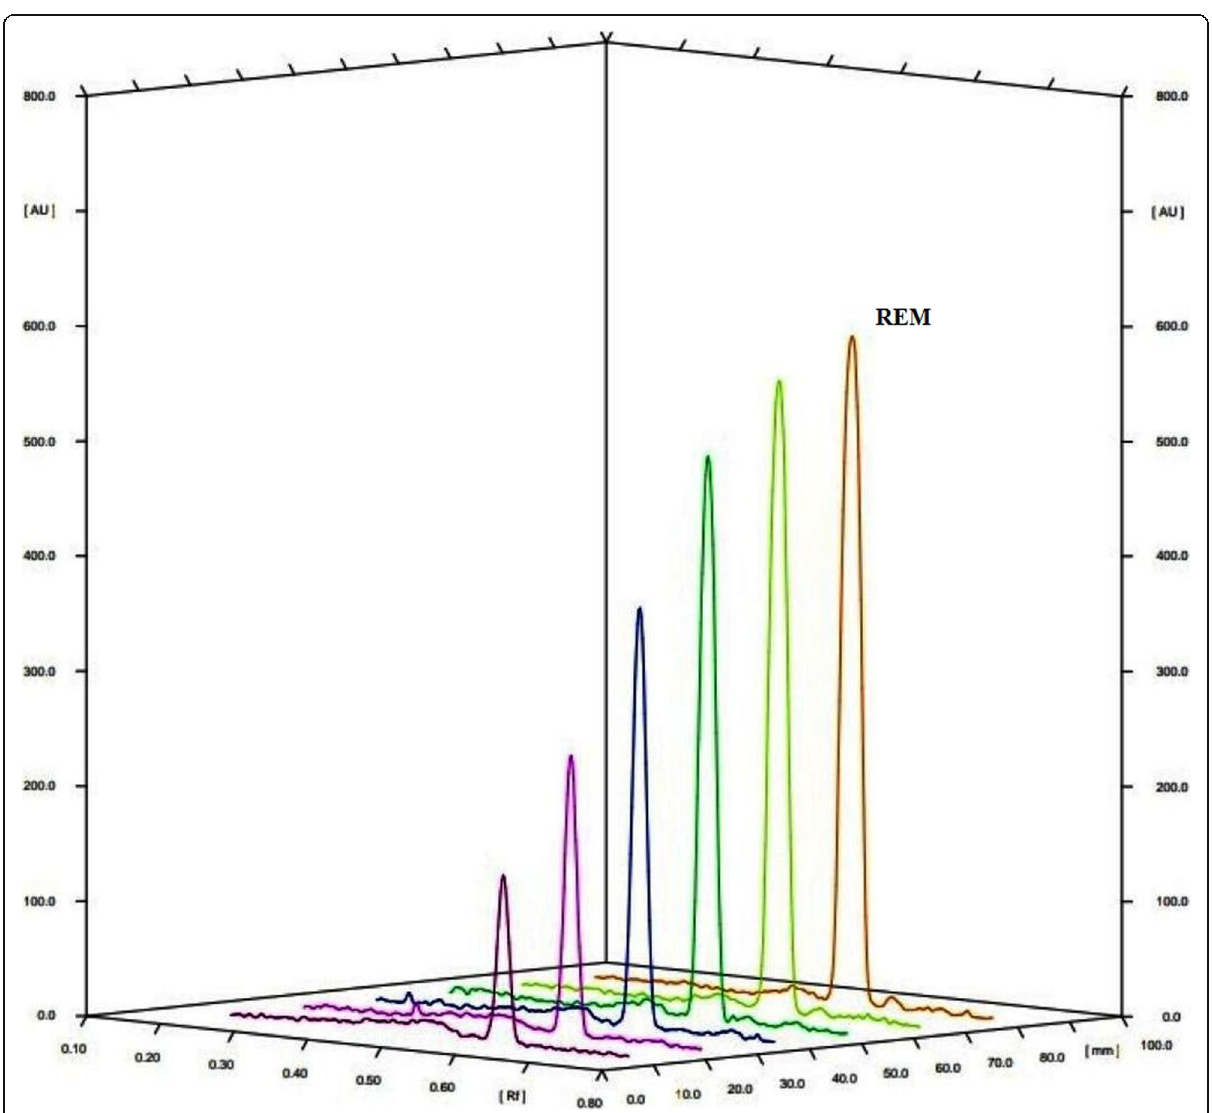
Fig. 4 Overlaid 3D densitogram of REM